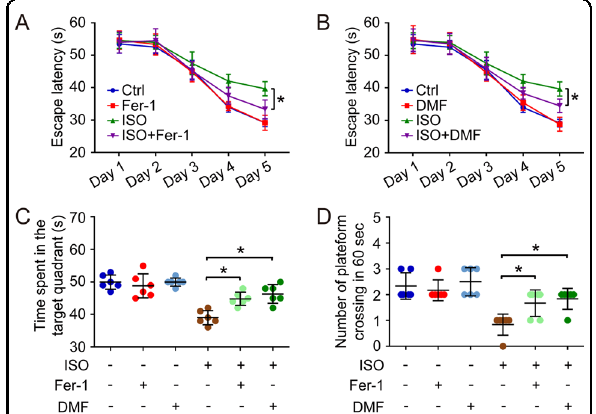
Fig. 6 Fer-1 and DMF relieve iso fl urane-induced learning and memory impairment. In the pre-treatment, 15 mg/kg DMF was administered (i.p.) 16 h before anesthesia, and 1 pmol of Fer-1 was injected into the striatum immediately before anesthesia. Then, the mice received iso fl urane exposure (ISO, 1.5%) for 6 h. 3 weeks later, the learning and memory ability of the mice in different groups were analyzed using Morris water maze test. Herein, the escape latency ( A ), the time spent in the target quadrant ( B ), and the number of plateform crossing in 60 sec ( C ) were calculated in each group. * p value < 0.05 compared between two